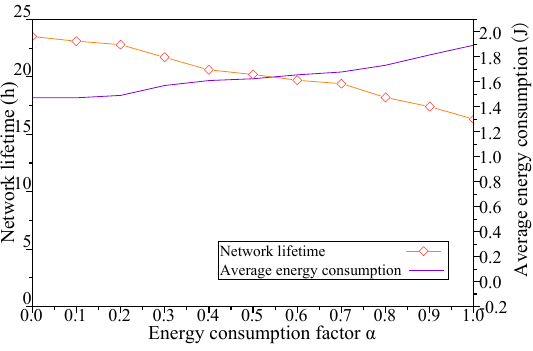
Figure 13. Influence of α on network lifetime and average energy consumption.